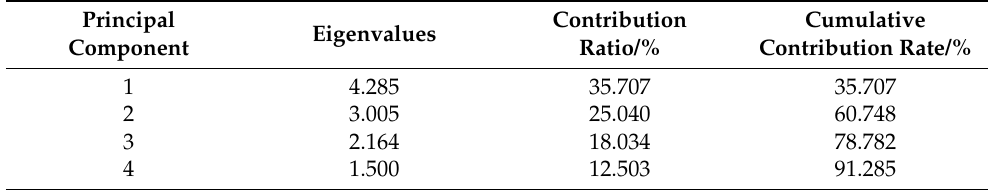
Table 8. The eigenvalues, contribution ratio, and cumulative contribution ratio of the principal components under severe drought